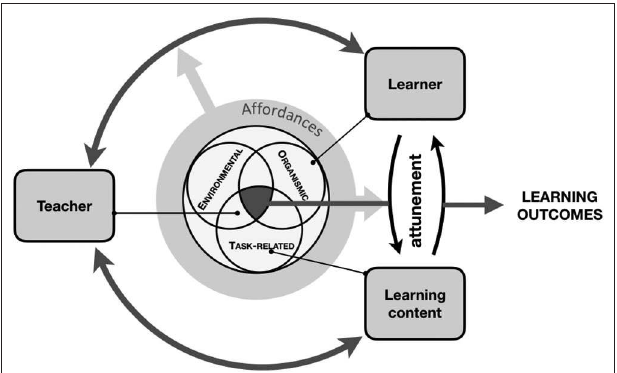
FIGURE 1 | Learning occurs within the learner-content-teacher triad, whereby the interaction between learner and learning content is shaped through the manipulation of a set of constraints. Through task design (e.g., tools and activities), the teacher creates a powerful learning environment. Within this learning environment, the teacher’s bodily involvement affects and is part of the task-related and environmental constraints. Thereby, the teacher creates affordances that support the learner’s attunement to the learning content and that provide the action possibilities that lead to desired learning